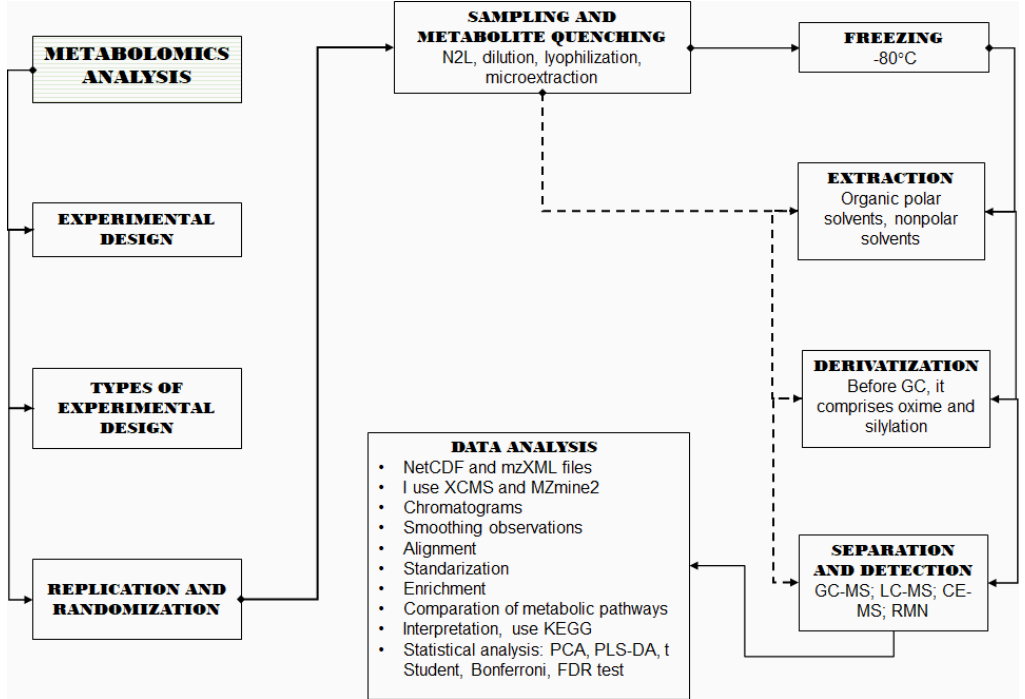
Figure 1. Synthesis of metabolic